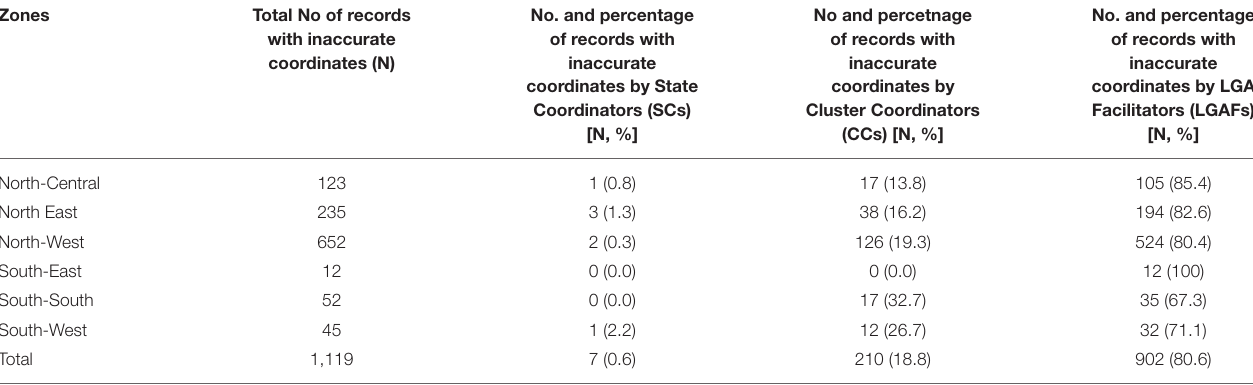
TABLE 3 | Number of records and those with inaccurate coordinates by political zone and cadres of officers reporting. Zones Total No of records